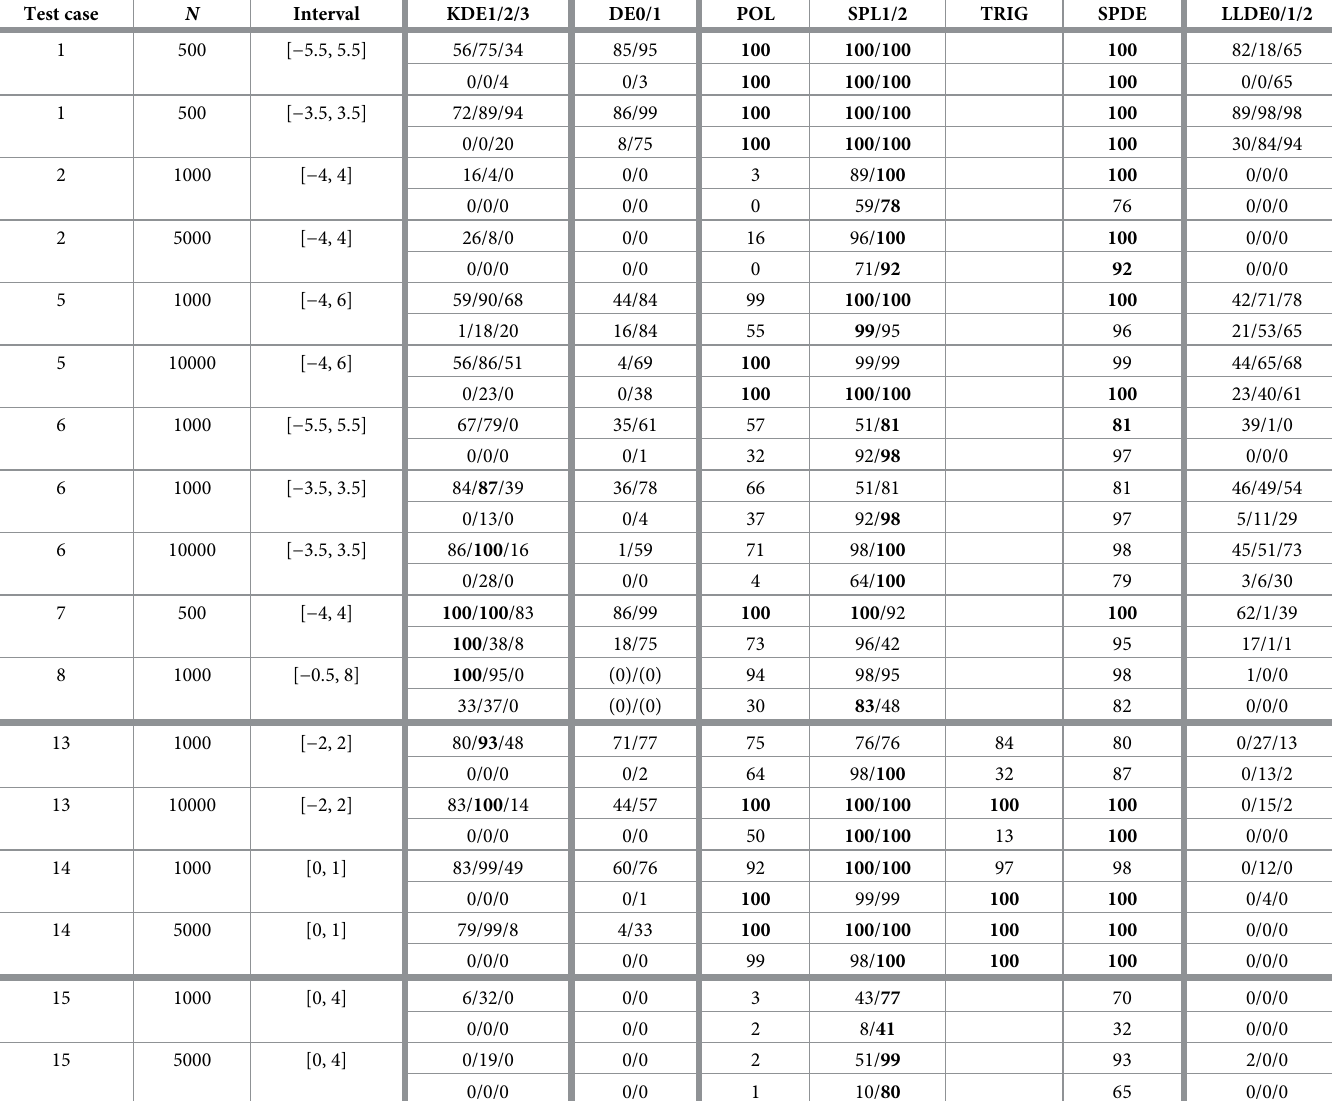
Table 5. Detection of modality: Number of realisations out of 100 in which the modality of the density is correctly identified. The upper row refers to modes, the lower row to bumps. Modes and bumps are counted on the indicated interval. For test cases 14 and 15, the semiparametric estimators allow for logarithmic boundary terms at any boundary point. The best method is indicated in bold. For test case 8, the diffusion estimators give reasonable density estimates in most realisations but are unstable in some realisations. See S3 Appendix for further